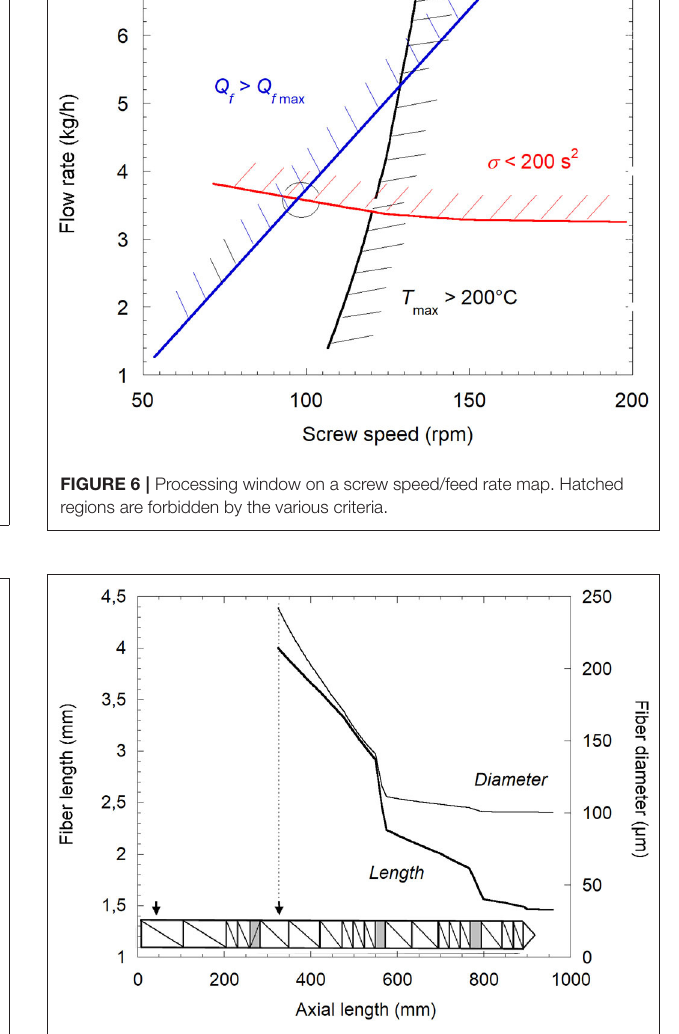
FIGURE 7 | Calculated changes in fiber length and diameter along the screw profile in the optimized